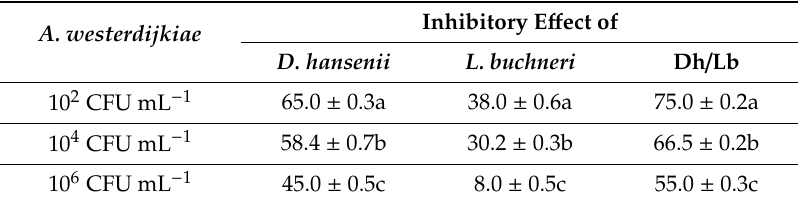
Table 5. Percentage of inhibitory e ff ect of D. hansenii and L. buchneri vs di ff erent concentration of